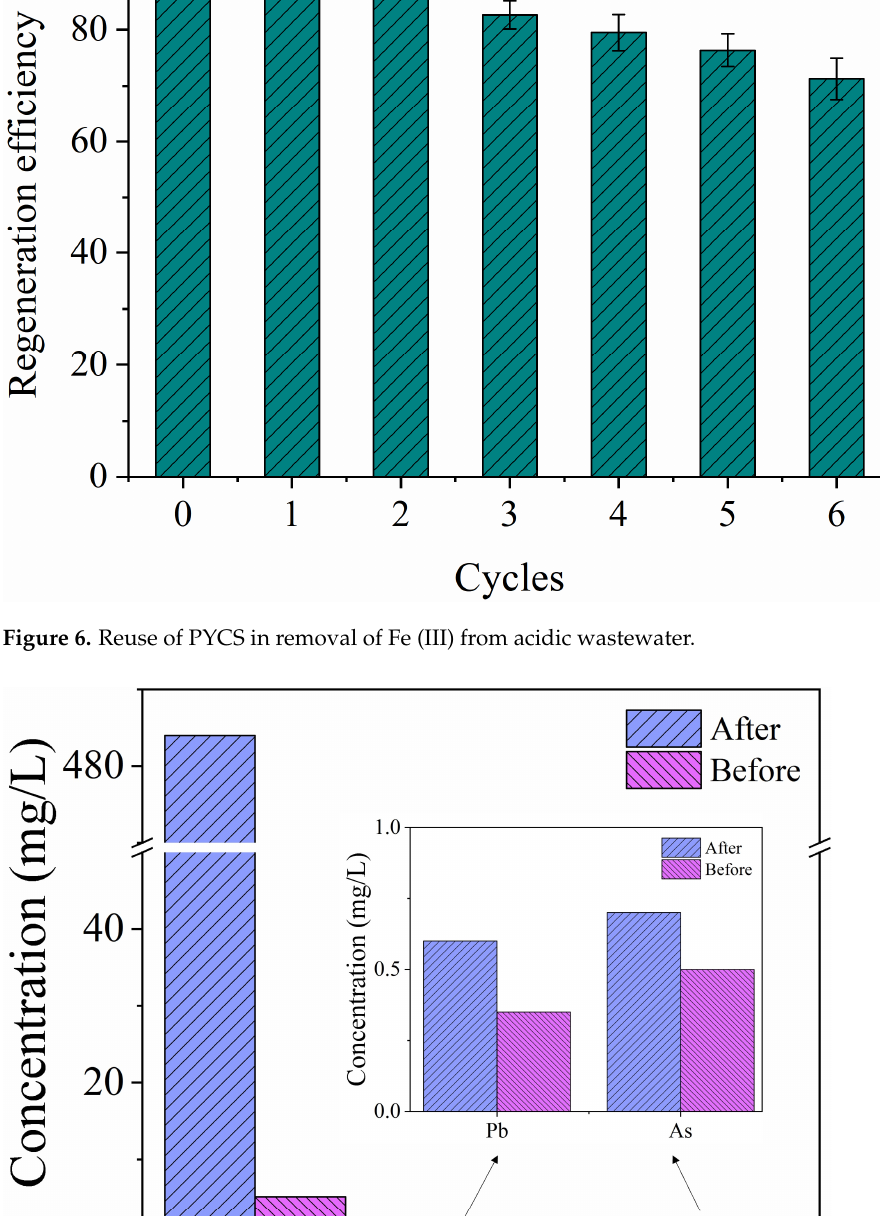
Figure 7. The removal of metal ions from real wastewater.